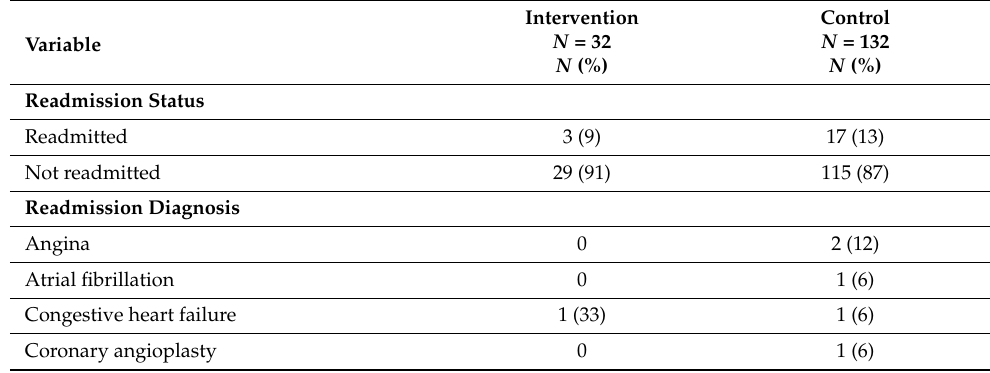
Table 4. Characteristics and readmission